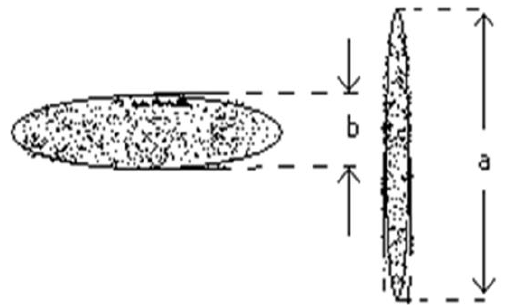
Fig. 3. Wheat grain geometric dimensions: (a) length, (b)